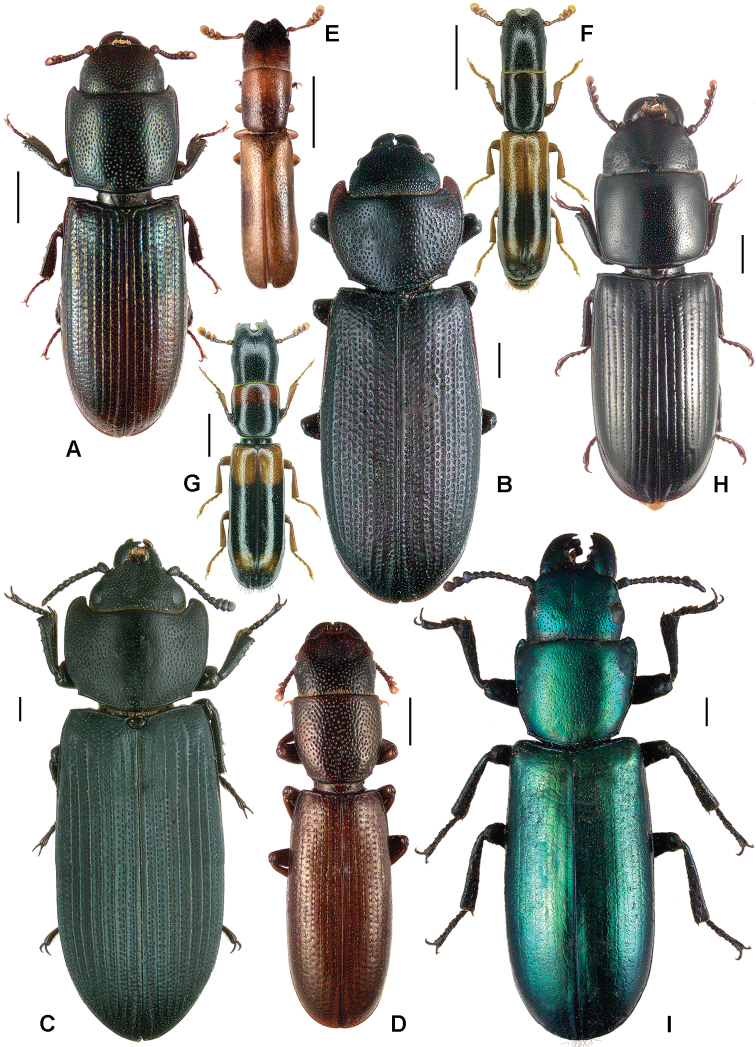
A
Eupycnus lentus
B
Melambia crenicollis
C
Melambia striata
D
Leipaspis lauricola
E
Nemozoma cornutum
F
Nemozoma elongatum
G
Nemozoma caucasicum
H
Parallelodera quadraticollis
I
Temnoscheila pini.